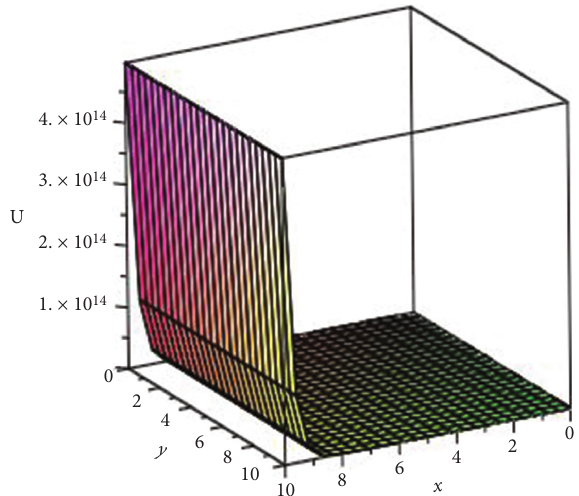
Figure 1: Graph of w given by (17) for C � 0.1, D � 1, and C